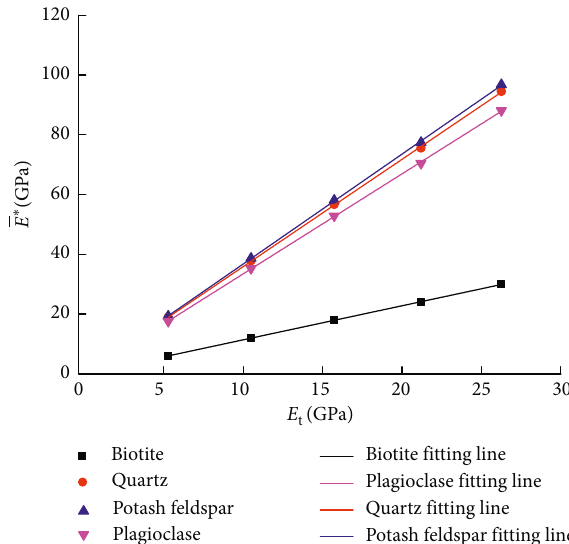
Figure 7: Relationships between the tensile Young’s modulus and parallel bond Young’s modulus of different minerals.